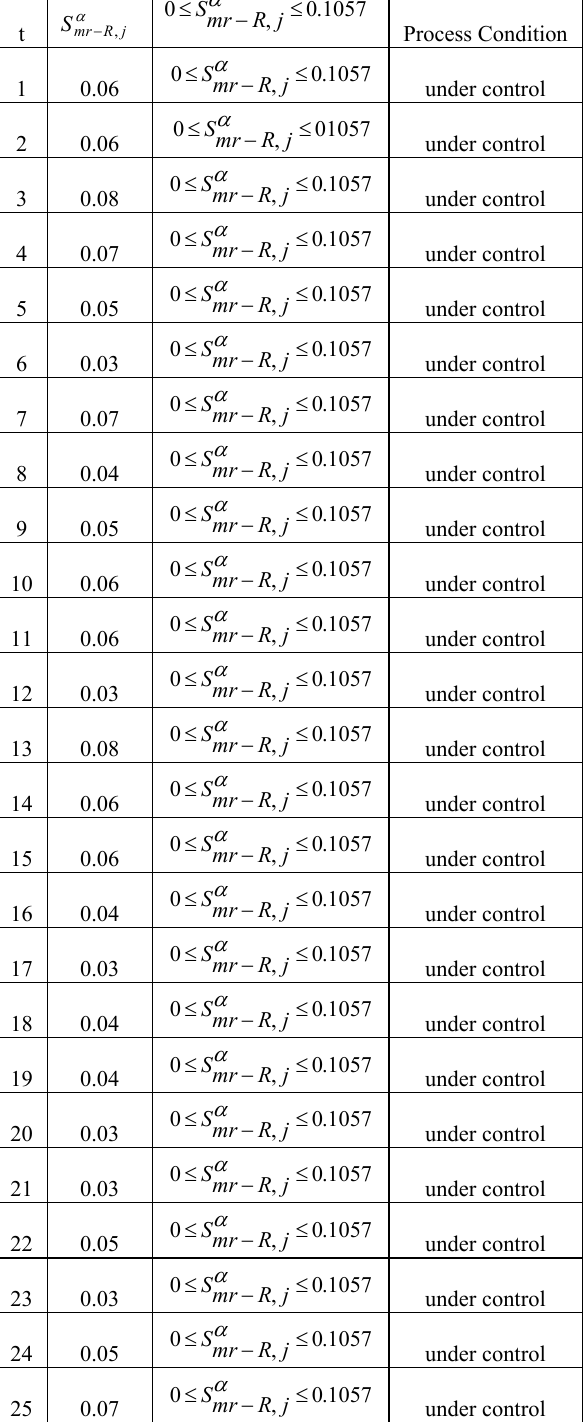
Table 6. Control limits using the α -level fuzzy midrange for an α -cut fuzzy R